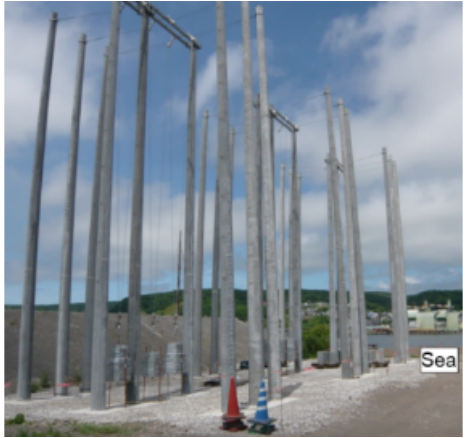
Figure 6. Exposure test of "CP500" utility poles at the Choshi test site in Japan (started in August 2010).